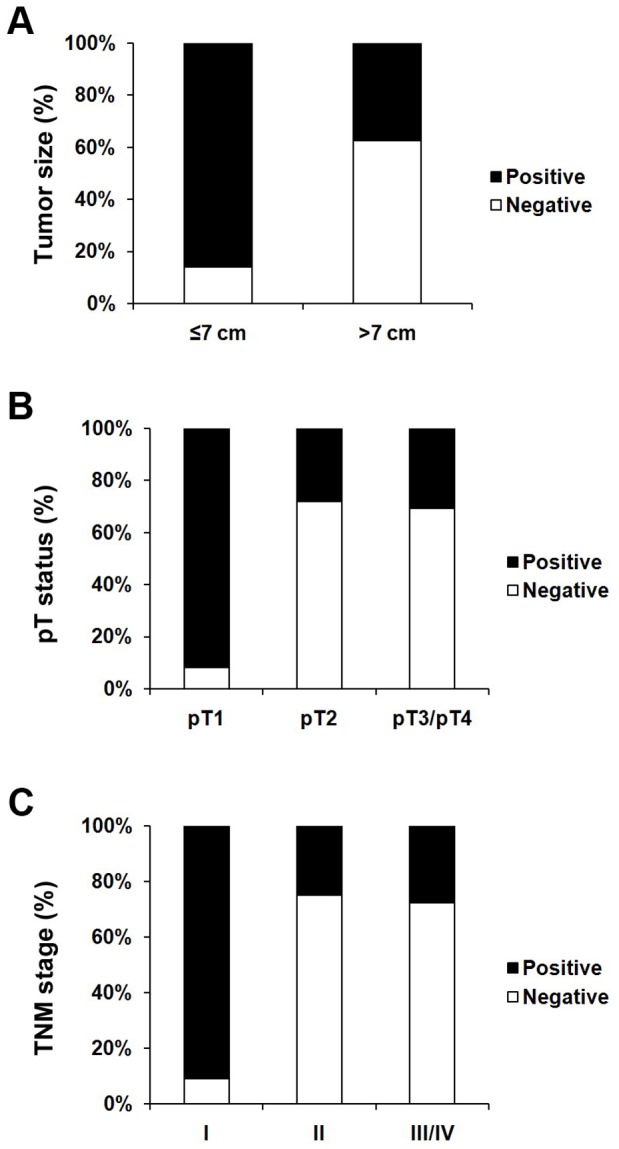
Correlation between RUNX3 expression and clinicopathologic parameters in RCC.A Decreased RUNX3 expression was correlated with tumor size (P<0.001, χ2 test, comparing ≤7 cm versus >7 cm). B Decreased RUNX3 expression was correlated with depth of invasion (P<0.001, χ2 test, comparing pT1 versus pT2–pT4). C Decreased RUNX3 expression was correlated with TNM stage (P<0.001, χ2 test, comparing I versus II–IV).